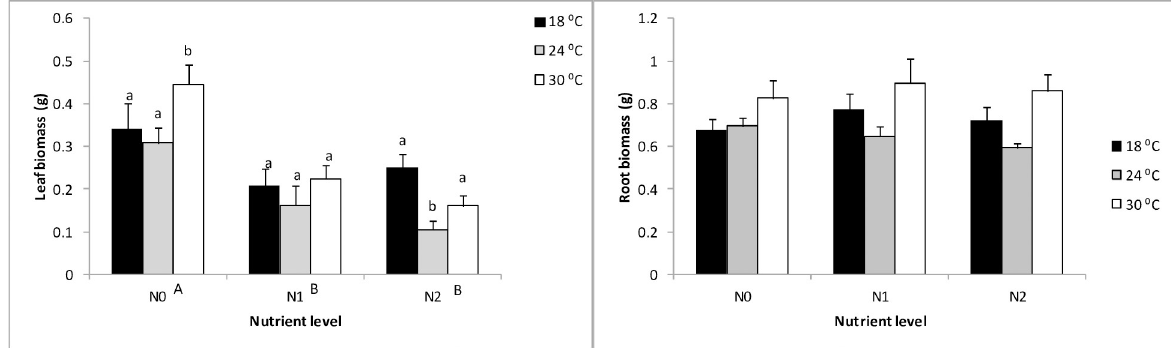
Fig 2. Main and interactive effects of temperature and nutrient treatments on above ground (A) and belowground biomass (B). Mean ± SE, n = 3. Different letters above bars denote differences between temperature levels within nutrient treatments. Different capital letters adjacent to nutrient levels denote differences among nutrient treatments.